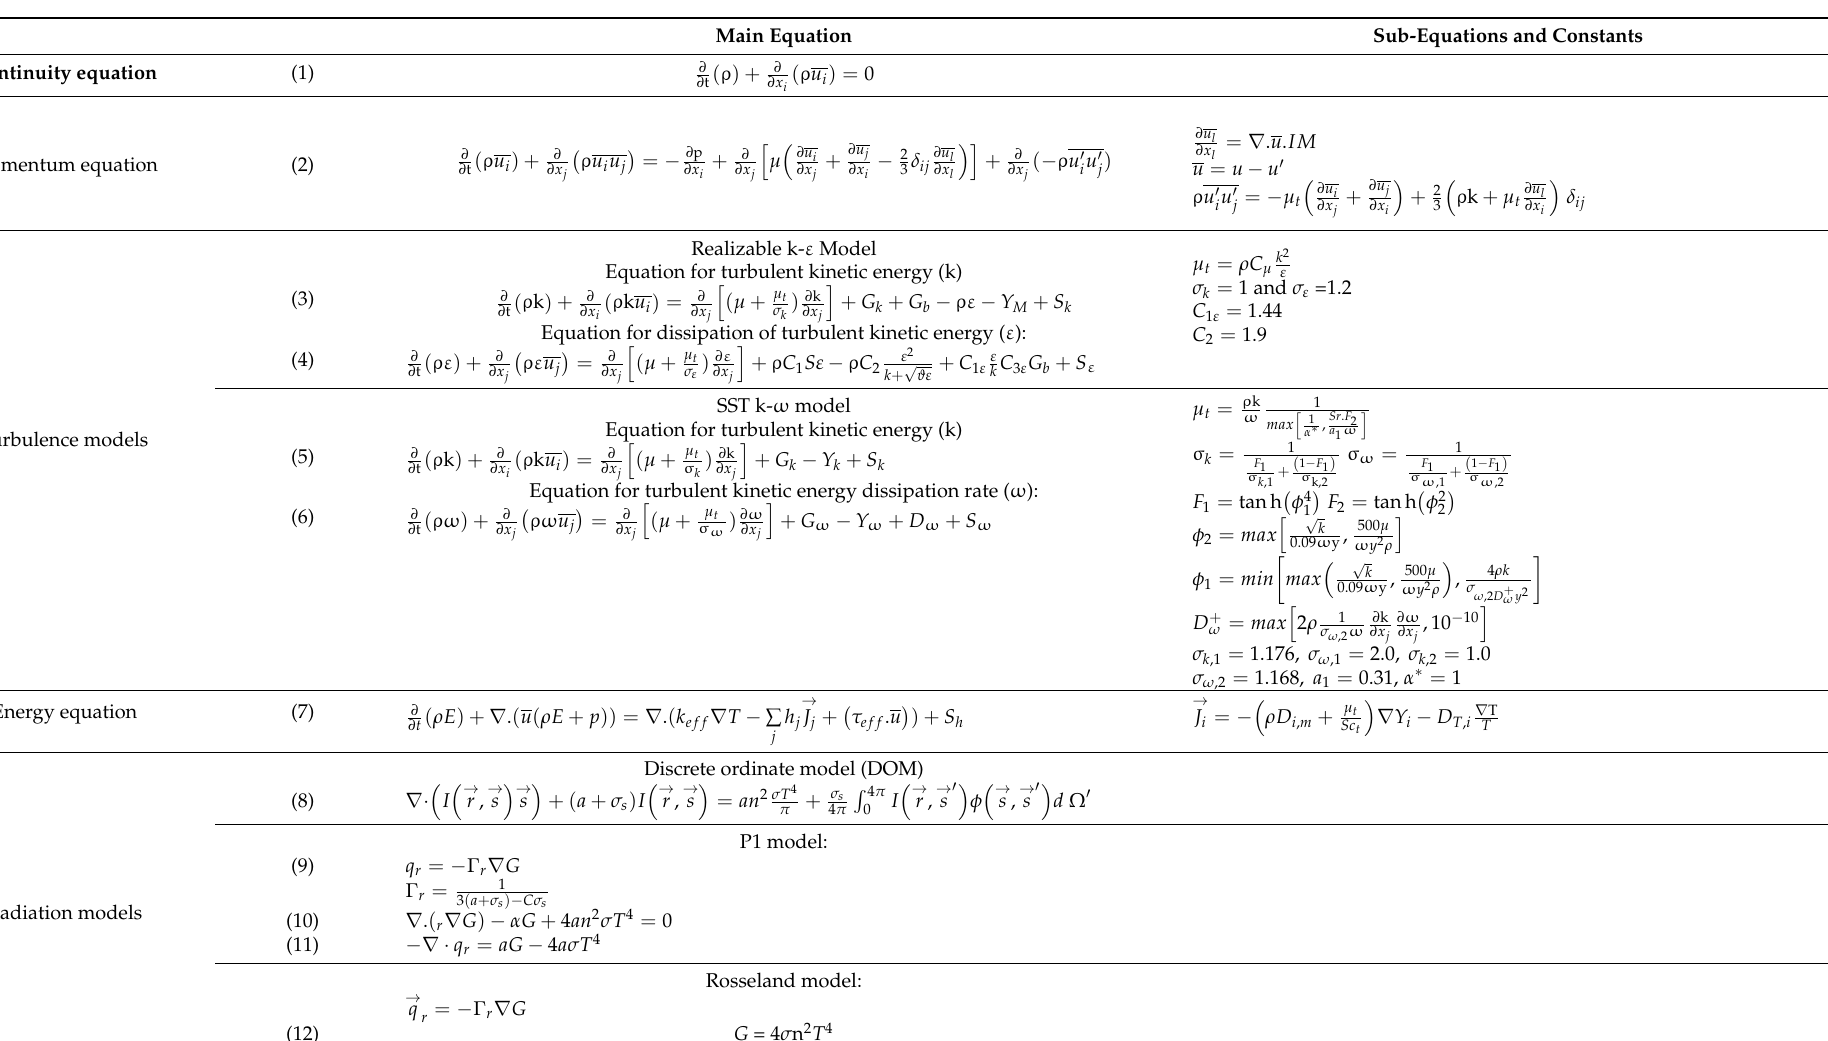
Table 1. Governing equations and sub-models for CFD modelling of HIsarna off-gas